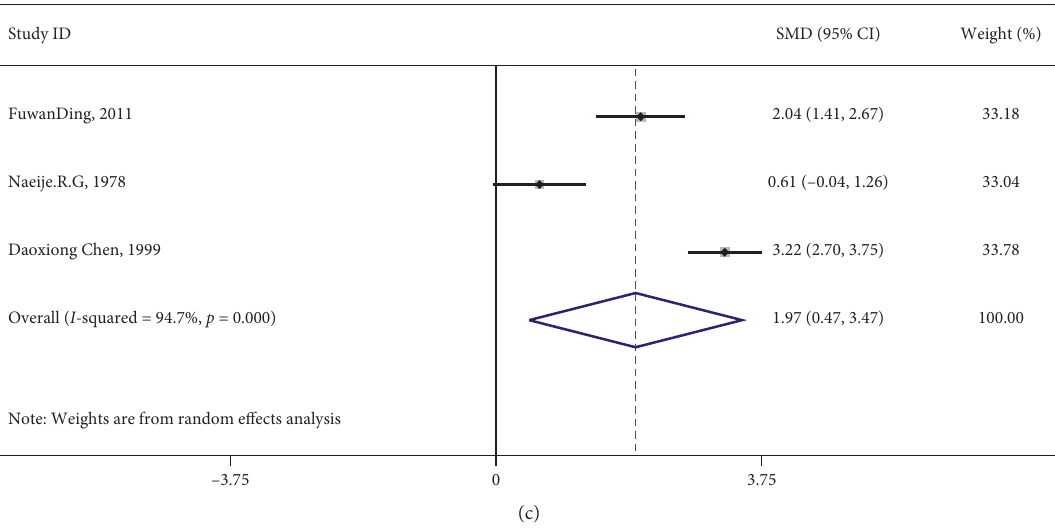
Figure 5: Forest plot of T4, T3, FT4, FT3, and rT3 compared with patients with DKA before and after treatment.